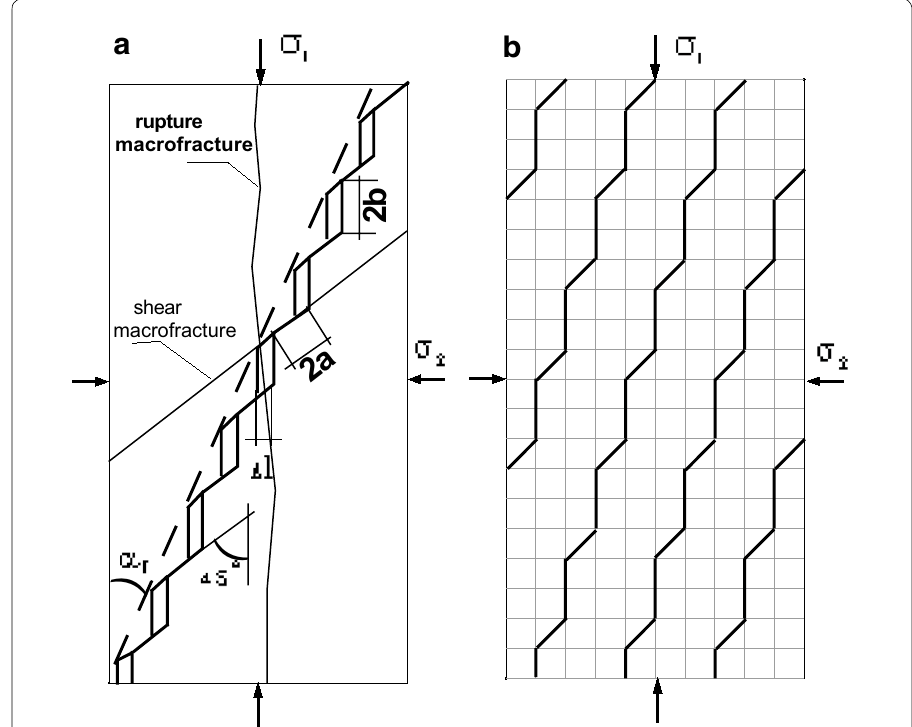
Fig. 2 Model of the shear failure by Stavrogin and Protosenya [26]: shear macrofracture ( a ) and failure micro- elements ( b